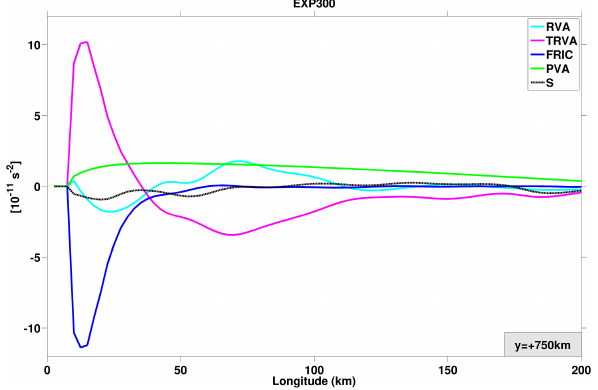
Figure 6. Thickness of the viscous sub-layer (VSL), the advective boundary layer (ABL) and the extended boundary layer (EBL) for all the experiments at different latitudes y